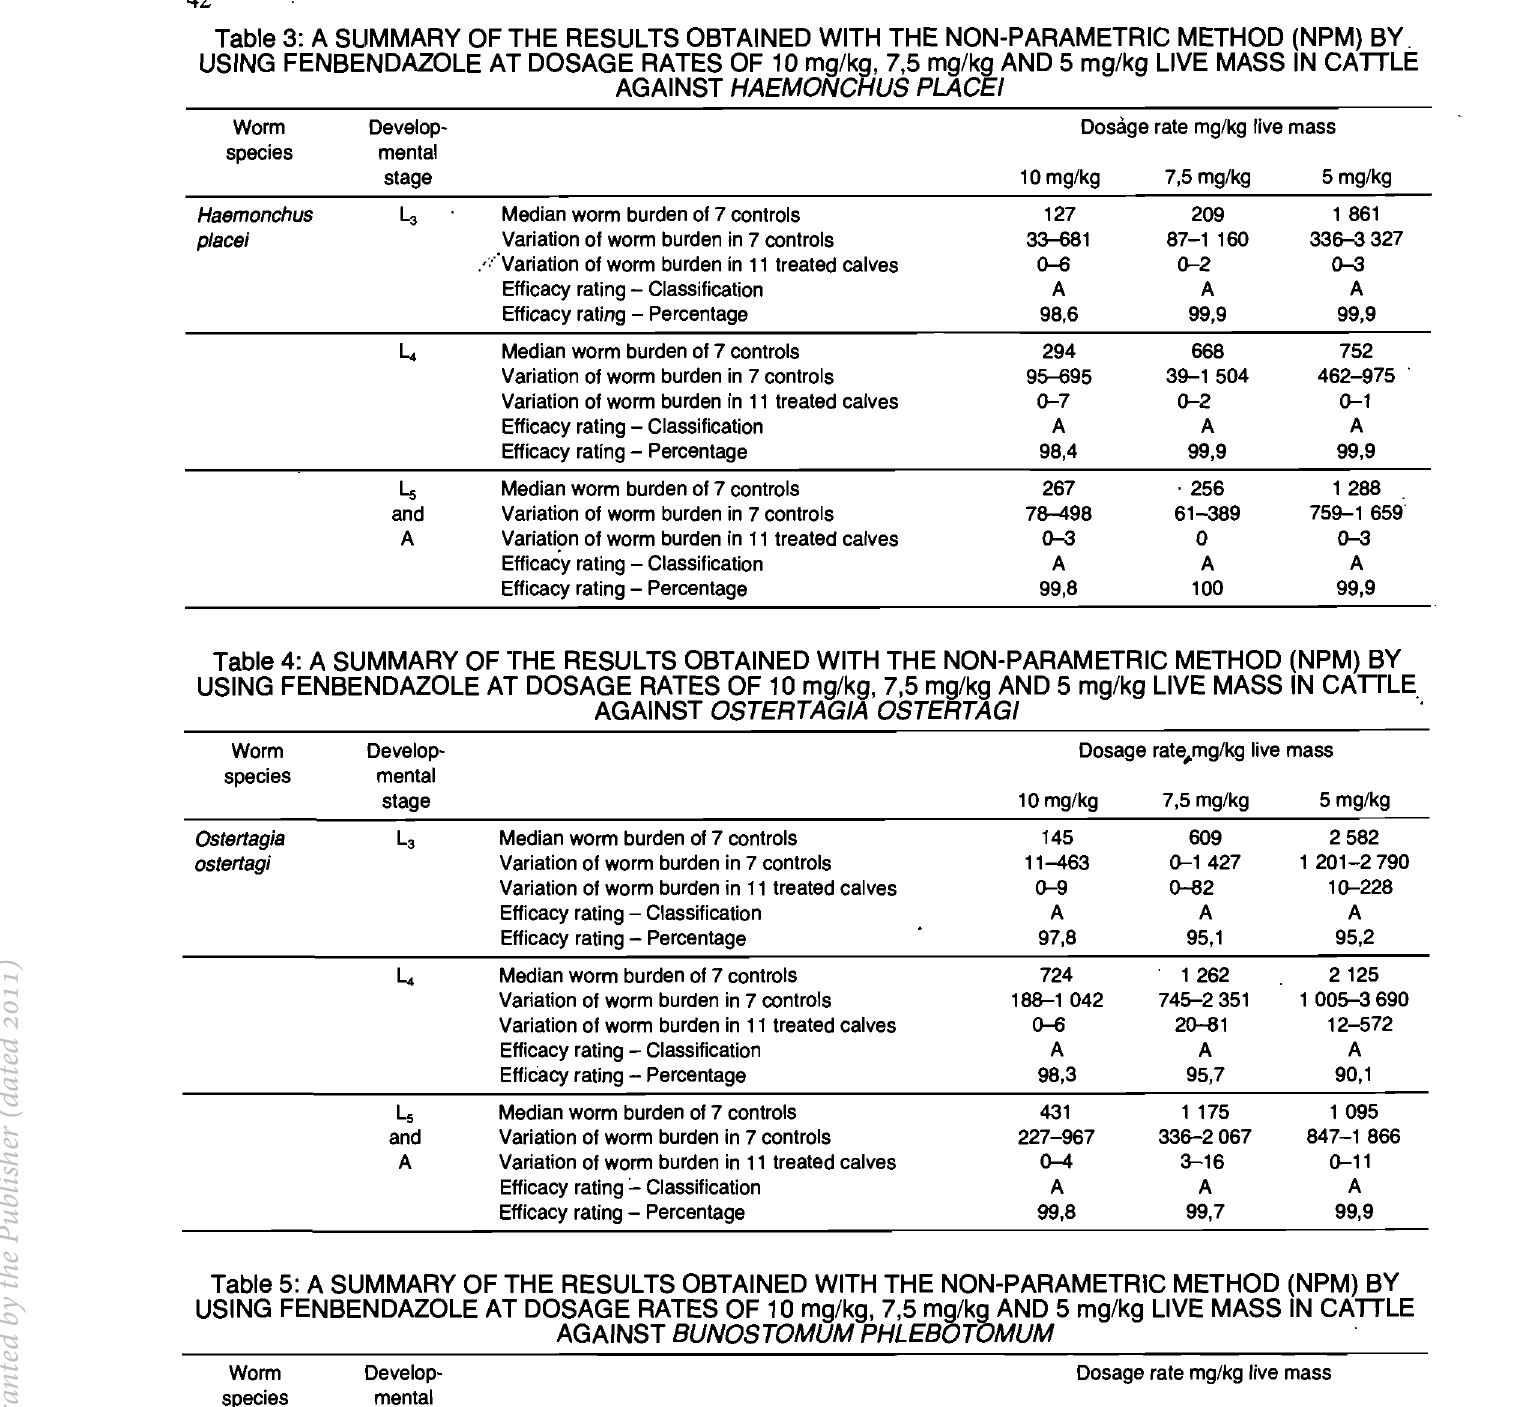
Table 3: A SUMMARY OF THE RESULTS OBTAINED WITH THE NON-PARAMETRIC METHOD (NPM) BY. USING FENBENDAZOLE AT DOSAGE RATES OF 10 mg/kg, 7,5 mg/kg AND 5 mg/kg LIVE MASS IN CATTLE AGAINST HAEMONCHUS PLACEI